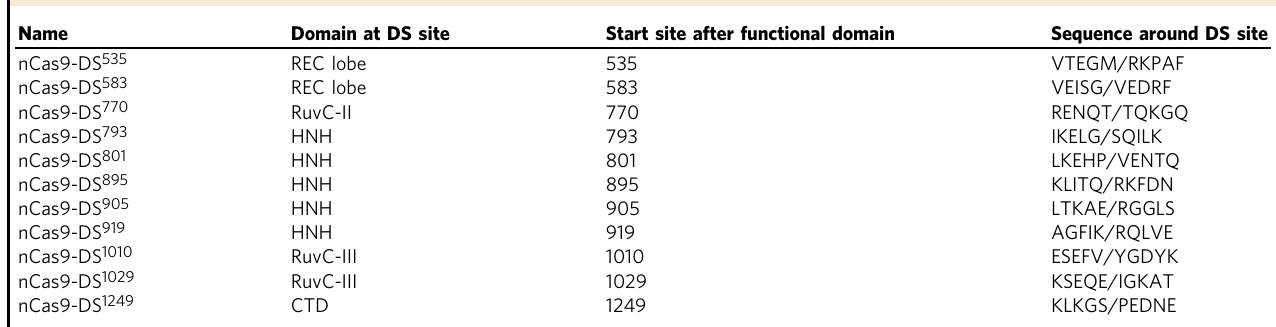
Table 1 Location summary of functional DSs for ABE-nSpCas-DS